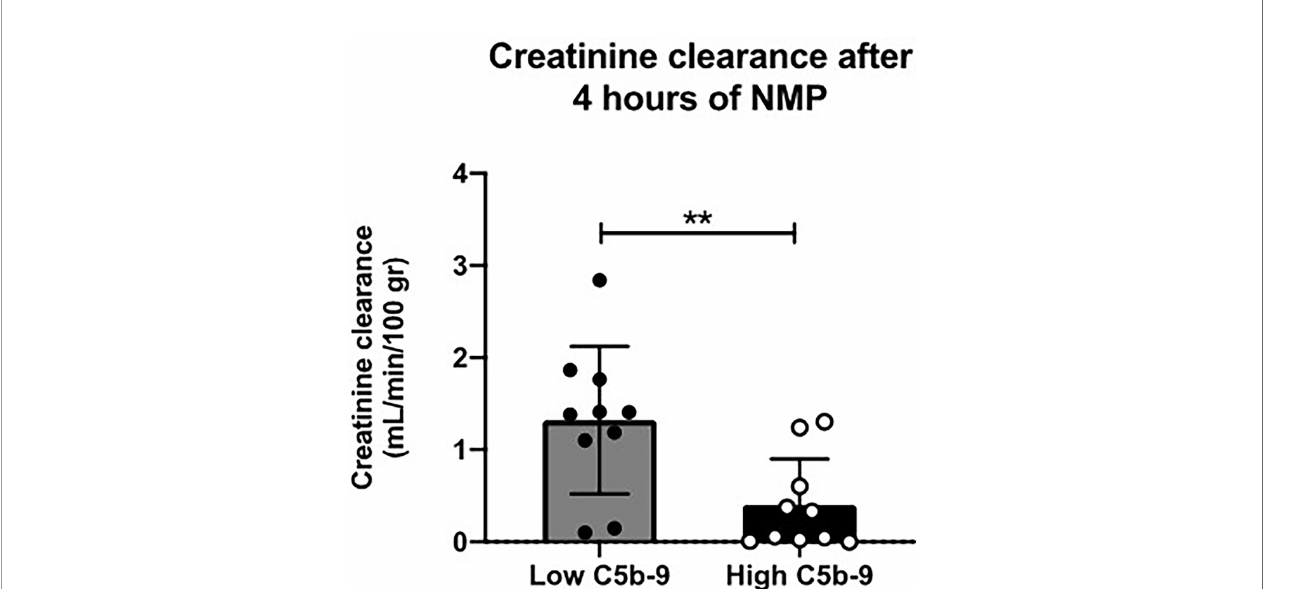
FIGURE 5 | Creatinine clearance after 4 h of normothermic machine perfusion of porcine kidneys with low versus high sC5b-9 perfusate levels. Kidneys ( n = 10) with low sC5b-9 perfusate levels after 4 h of normothermic machine perfusion (NMP) had signi fi cantly higher creatinine clearance than kidneys ( n = 10) with high sC5b-9 perfusate levels after 4 h of NMP. Subgroups were based on the median sC5b-9 perfusate level after 4 h of NMP, which was 105 AU/ml. ** p < 0.01. NMP, normothermic machine perfusion; sC5b-9, soluble